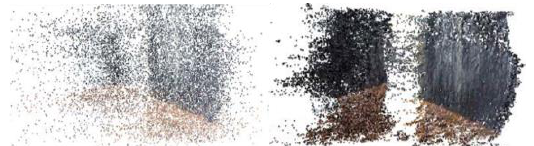
Figure 11. Photogrammetric 3D dense cloud for the real images.